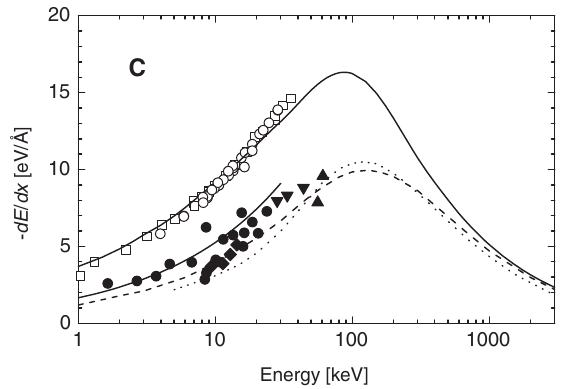
FIG. 2. Measured stopping power for protons (open symbols) and antiprotons (closed symbols) in solid carbon foils, repro- duced from [16]. The lines show predictions of various theories. The Barkas effect is clearly